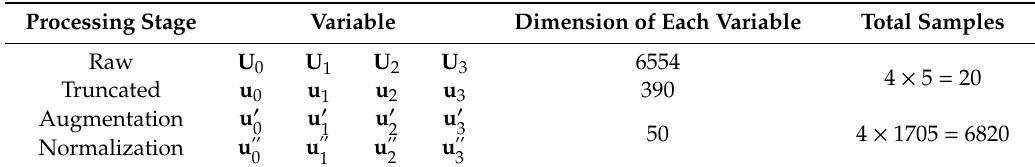
Table 1. The dataset details of training and test.